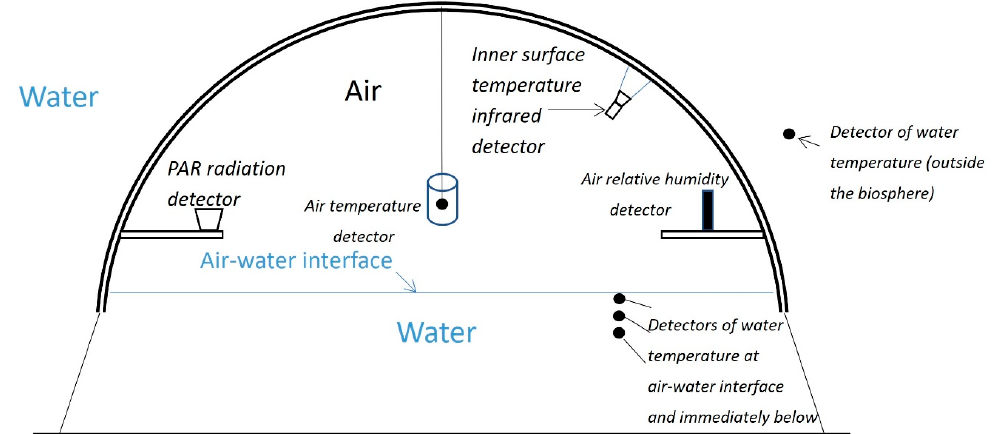
Figure 4. Location of the sensors employed in the experiment.